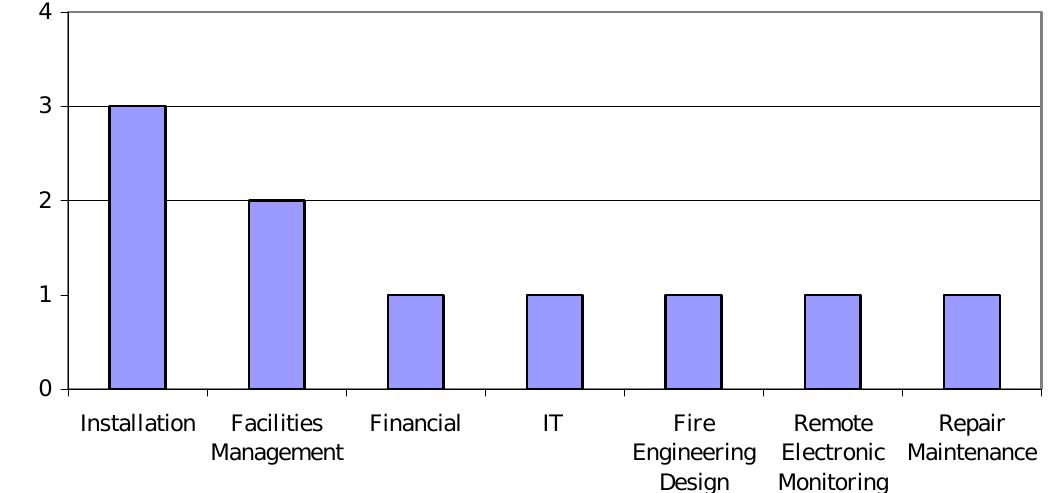
Figure 4: The newest service offered, by number of